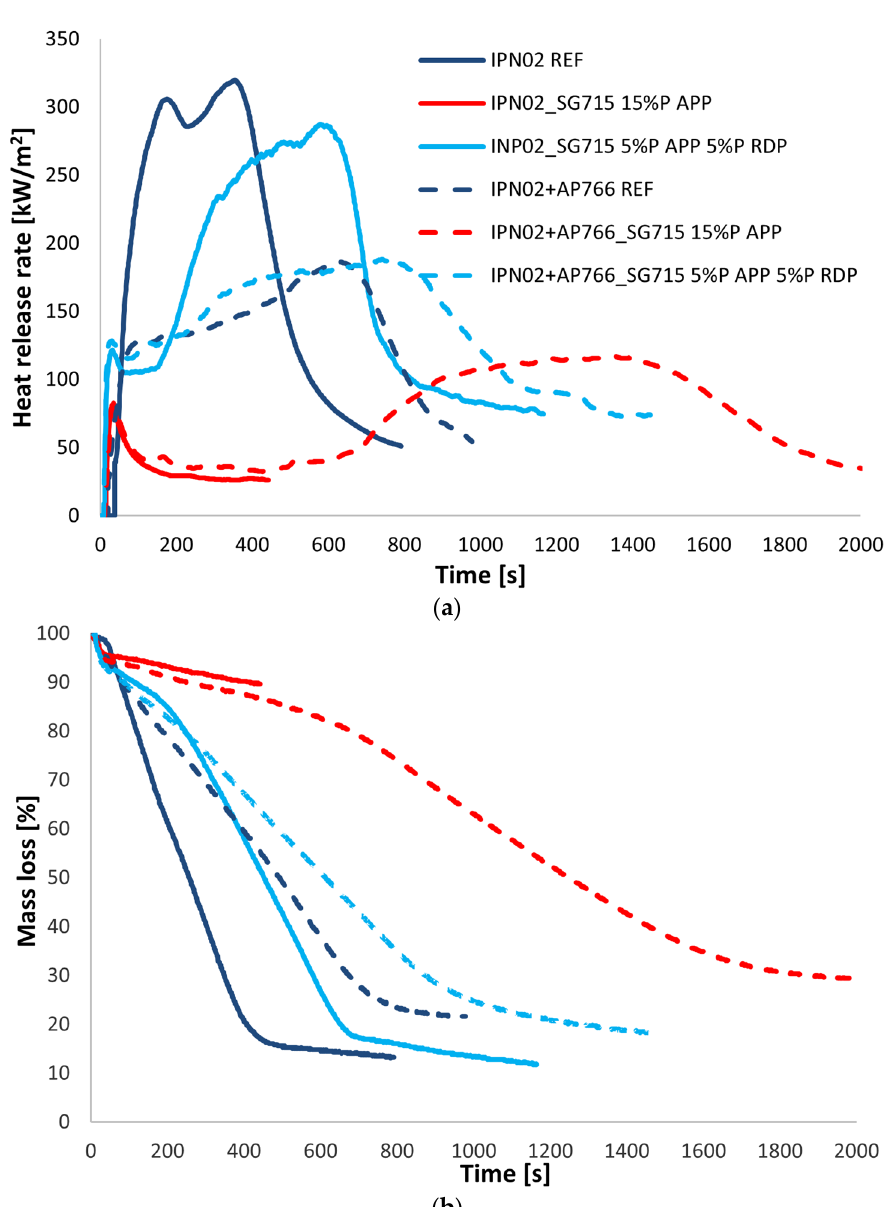
Figure 3. The heat release ( a ) rate and the mass loss ( b ) of IPN02-based reference and flame-retarded samples with and without coating.